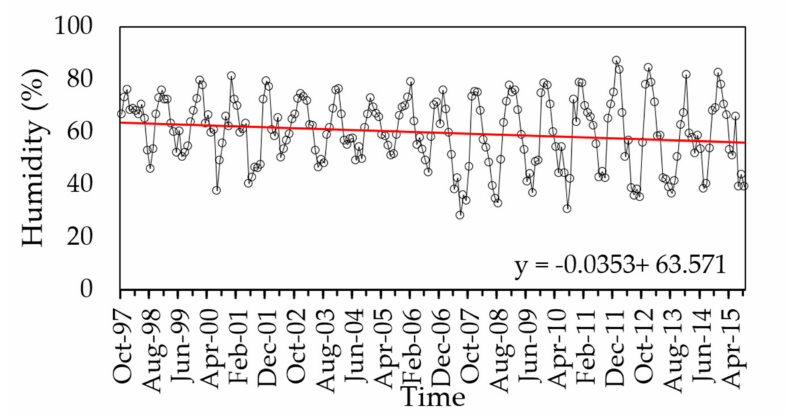
Figure 4. Time series and linear trend analyses of precipitation data between 1997 and 2015.